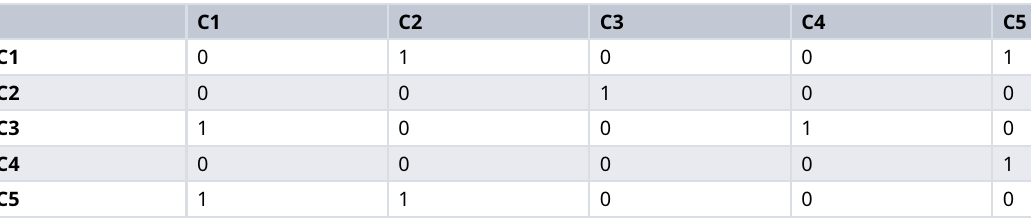
Table 9. Adjacency Matrix of a Fuzzy Cognitive Map